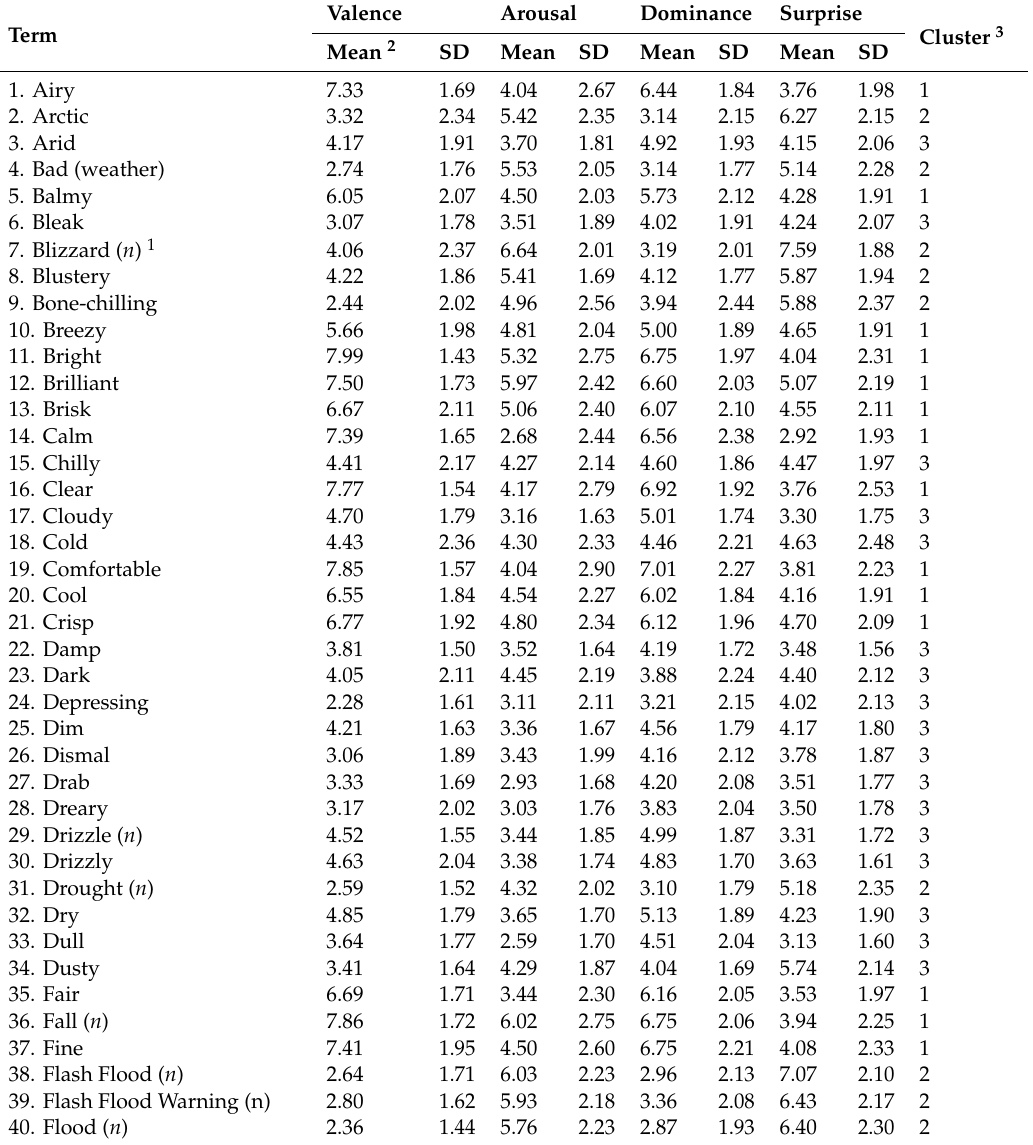
Table 1. Descriptive statistics for weather words rated on valence, arousal, dominance, and